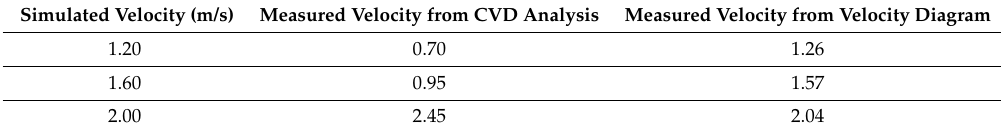
Table 3. Comparison of the measured velocity with the simulated velocity.